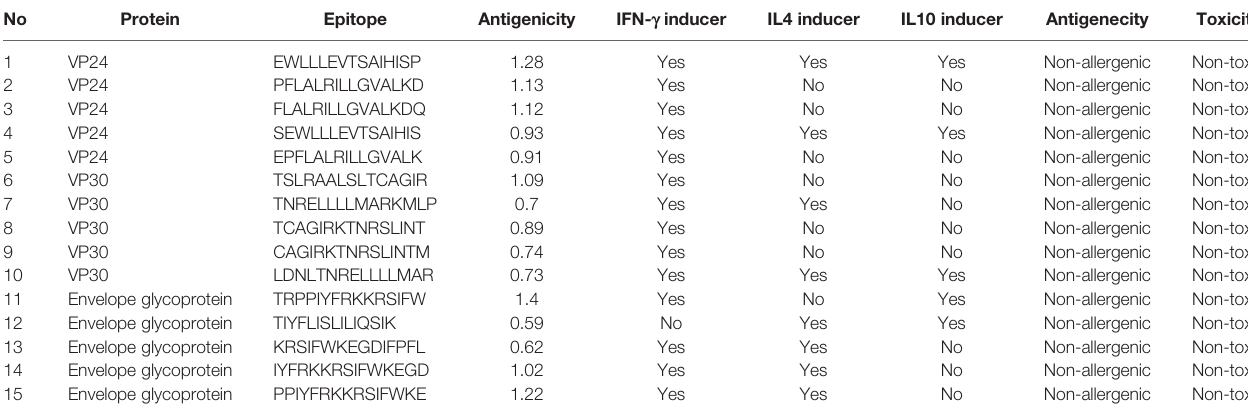
TABLE 3 | Top-ranked T-cell epitopes (MHC-II peptides) of VP24, VP30, and envelope glycoprotein.